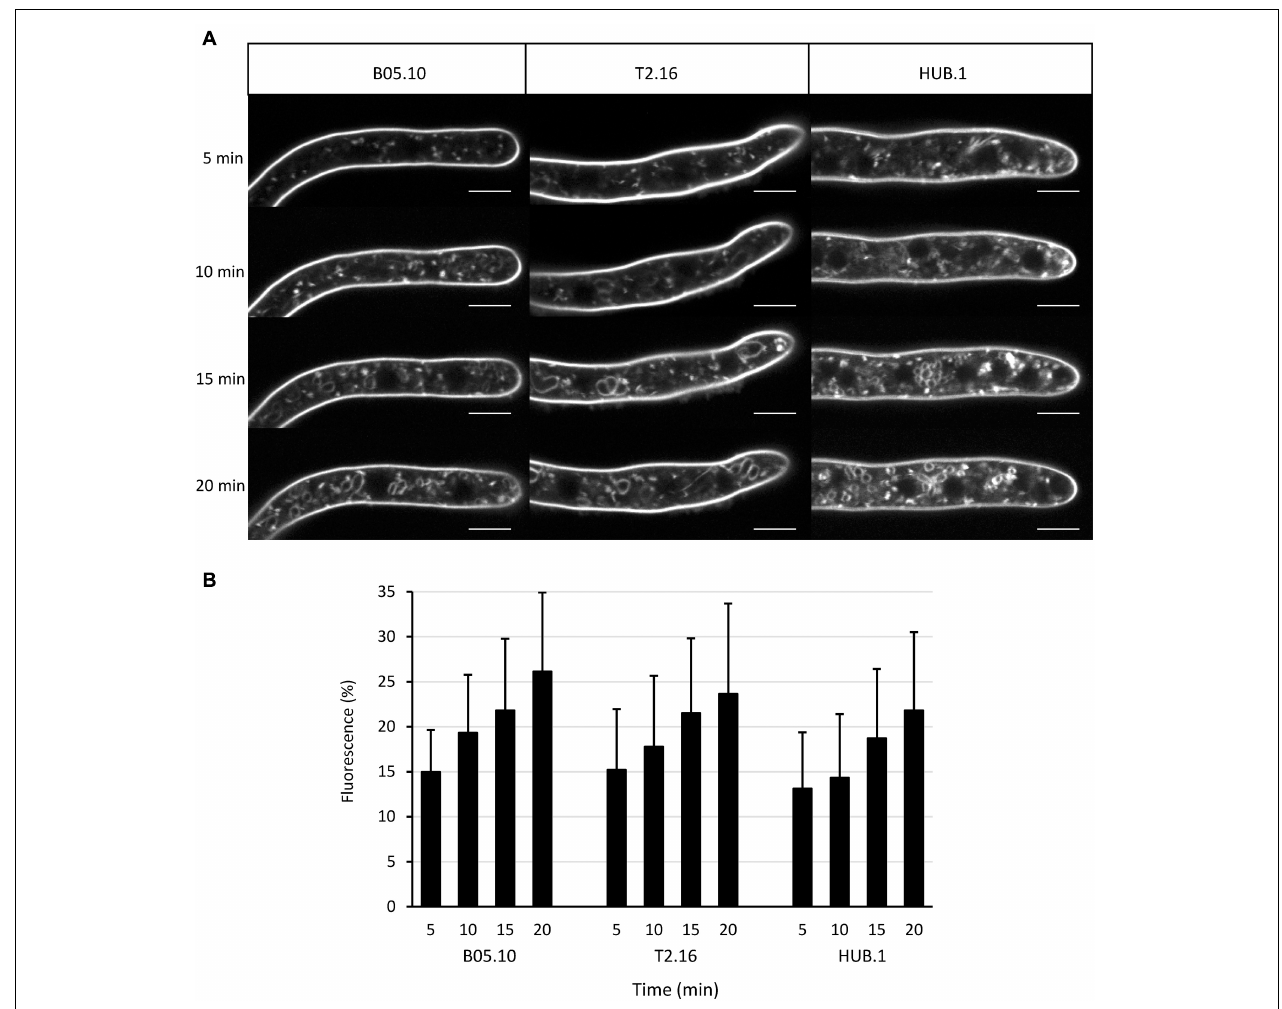
FIGURE 2 | Endocytosis in the clathrin mutants. (A) Observation of endocytosis by confocal microscopy. Labeling of the plasma membrane by the fluorescent lipophilic marker FM4-64 and its subsequent cellular internalization were monitored over time in young hyphae (16 h culture) of the parental (B05-10) and mutant (T2.16, HUB.1) strains (scale bar: 5 µ m). (B) Endocytosis quantification. For 10 different hyphae of each strain, image analysis of the 20 µ m apical region led to separate quantifications of the mean total cytoplasmic and mean plasma membrane fluorescence. The plot shows the normalized increase in mean cytoplasmic fluorescence over time (% of plasma membrane fluorescence) in each strain. Standard deviations (10 replicates) are